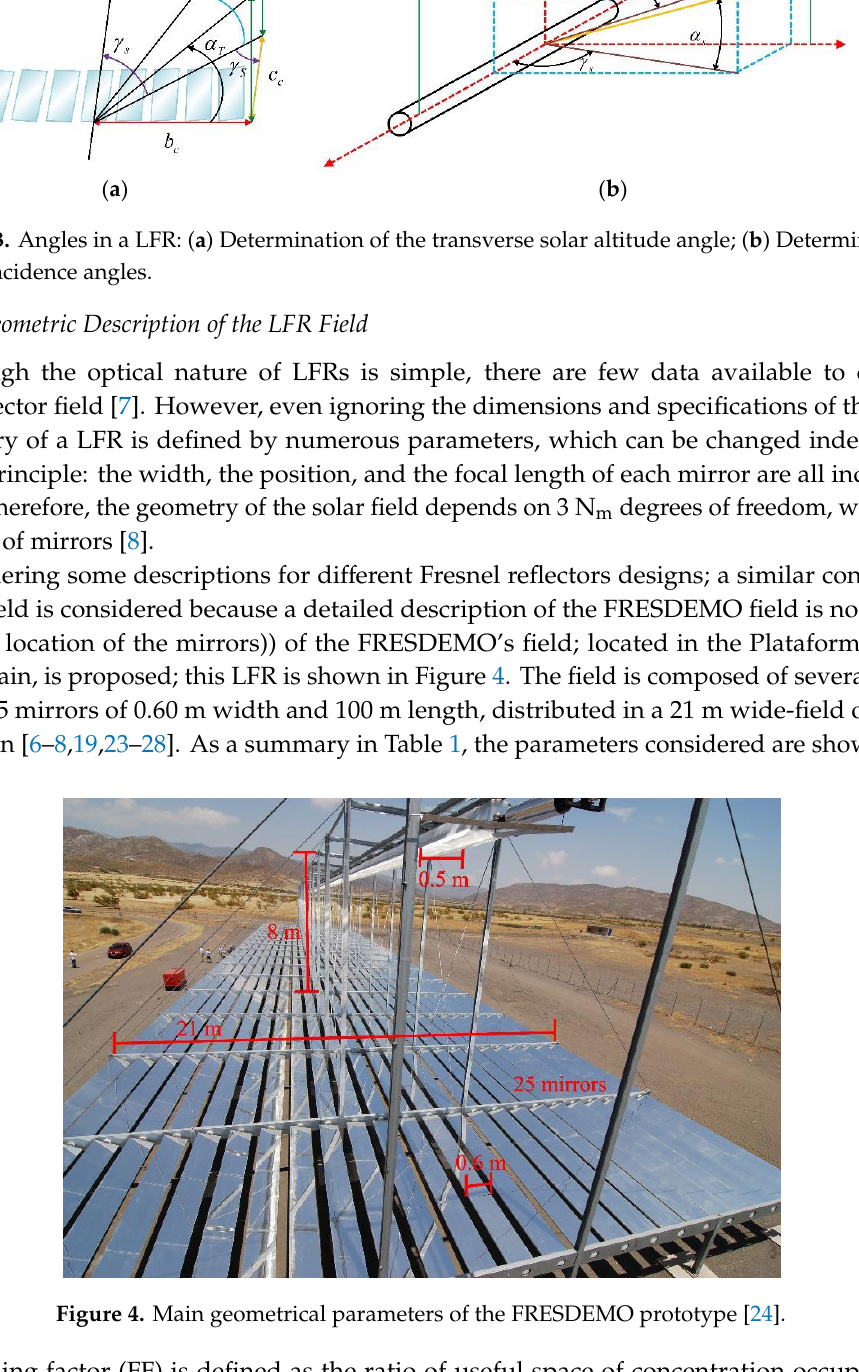
Figure 4. Main geometrical parameters of the FRESDEMO prototype [24].